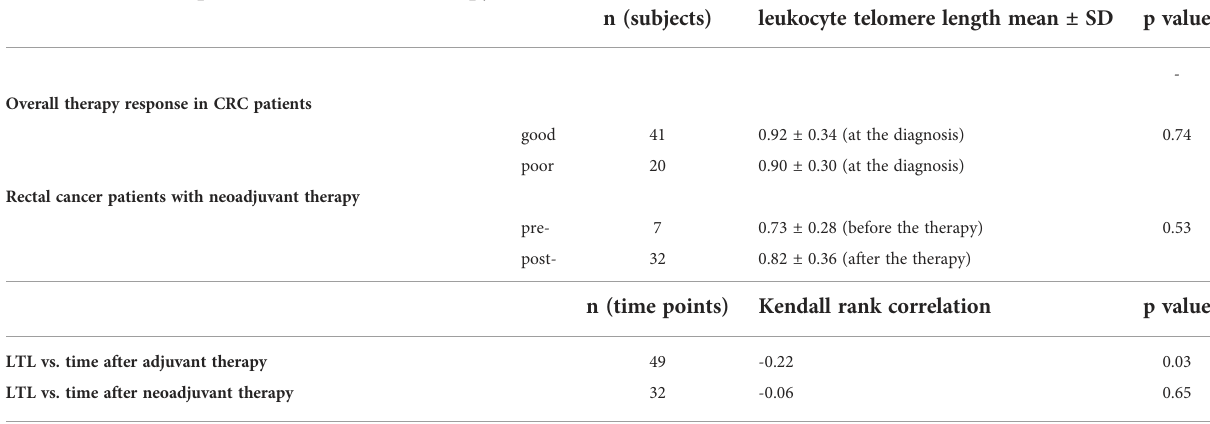
TABLE 4 Leukocyte telomere length with respect to treatment response and therapy effect. Strati fi cation of the patients based on their therapy